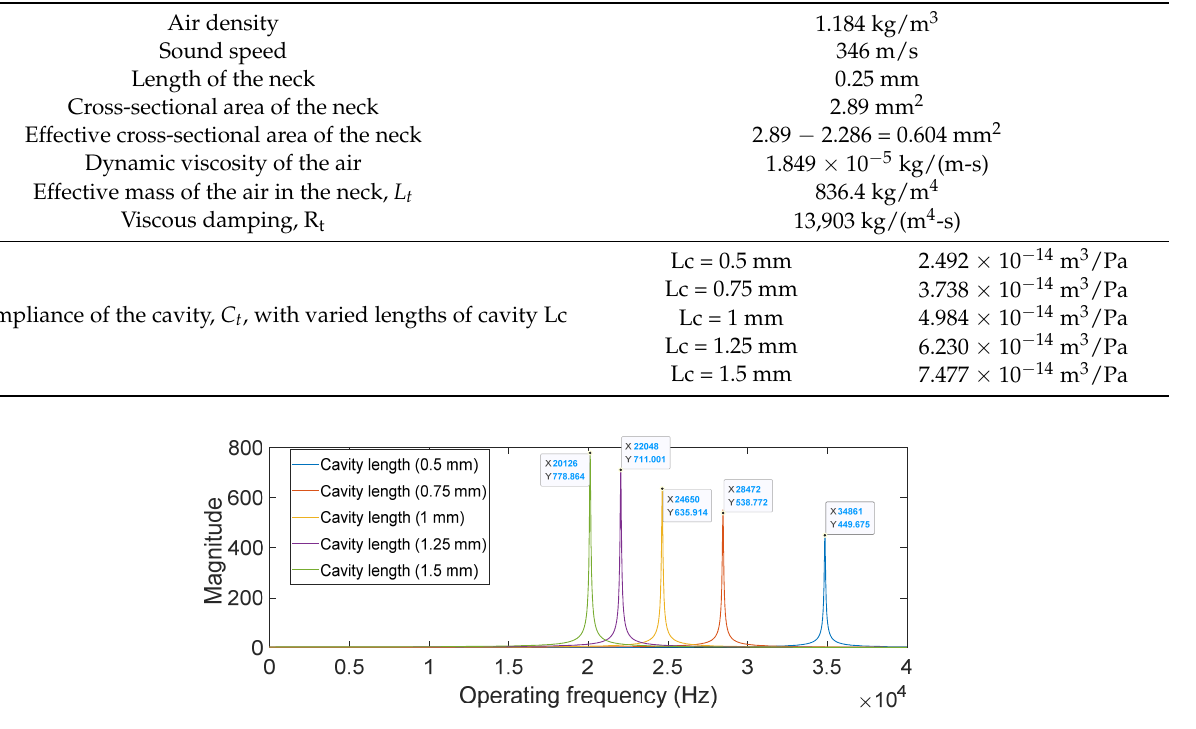
Figure 13. The calculated results of the transfer function Gt ( s ) = P 2( s )/ P 1( s ) based on the conventional Helmholtz resonator model and the physical parameters of the fabricated device.